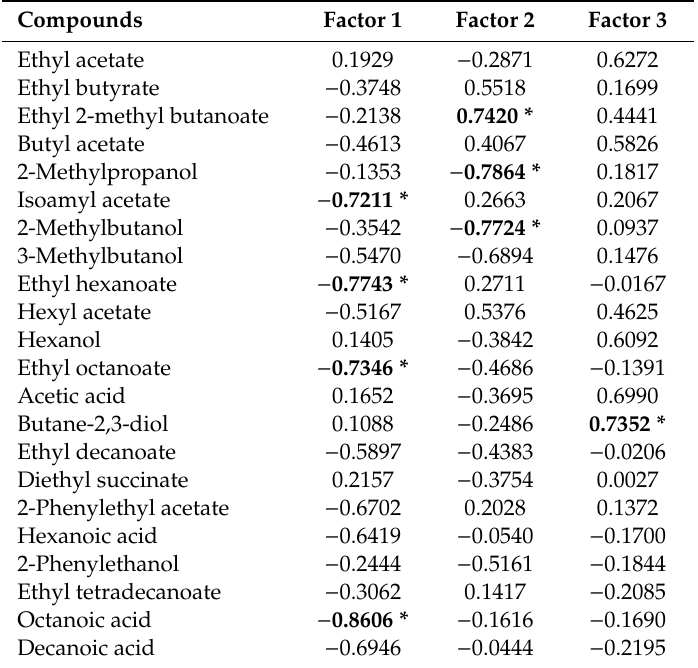
Table 2. Factor loading of the individual compounds in craft / intensified